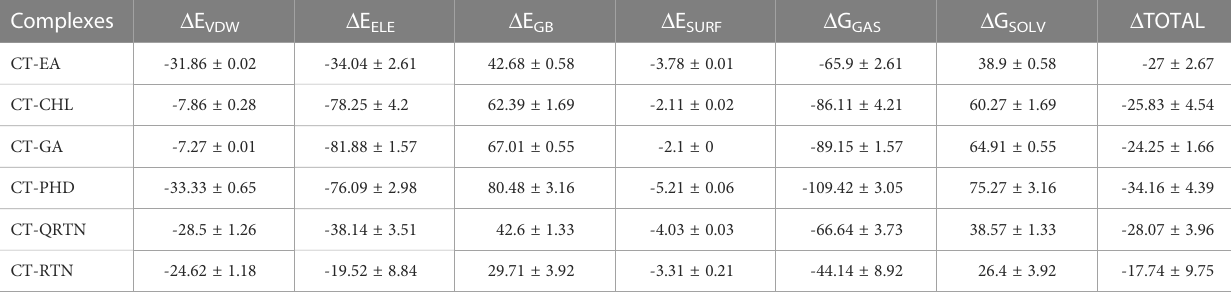
TABLE 2 Calculation of binding free energy (in kcal/mol) of six complexes using ‘ gmx_MMPBSA ’ tool.